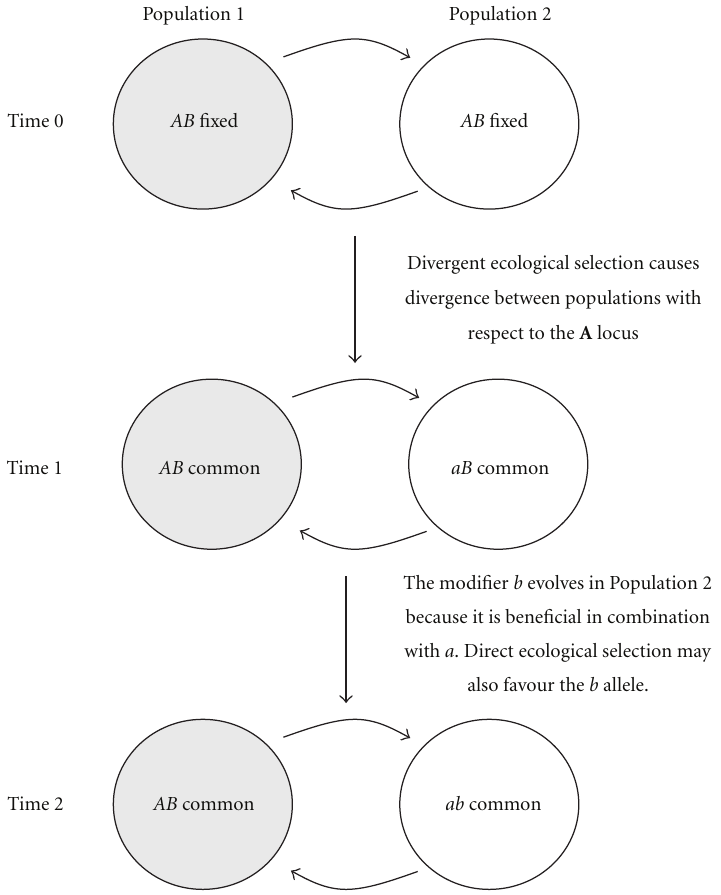
Figure 1: Divergent selection and the evolution of intrinsic isolation. Time 0: Two populations, connected by migration inhabit di ff erent environments. Both are initially fixed for the AB genotype. Time 1: Divergent ecological selection has caused divergence at the A locus, with the a allele evolving to high frequency in Population 2. Time 2: The modifier b evolves in Population 2, either because it ameliorates a pleiotropic cost of the a allele (Model 1) or because the B locus also experiences divergent ecological selection (Model